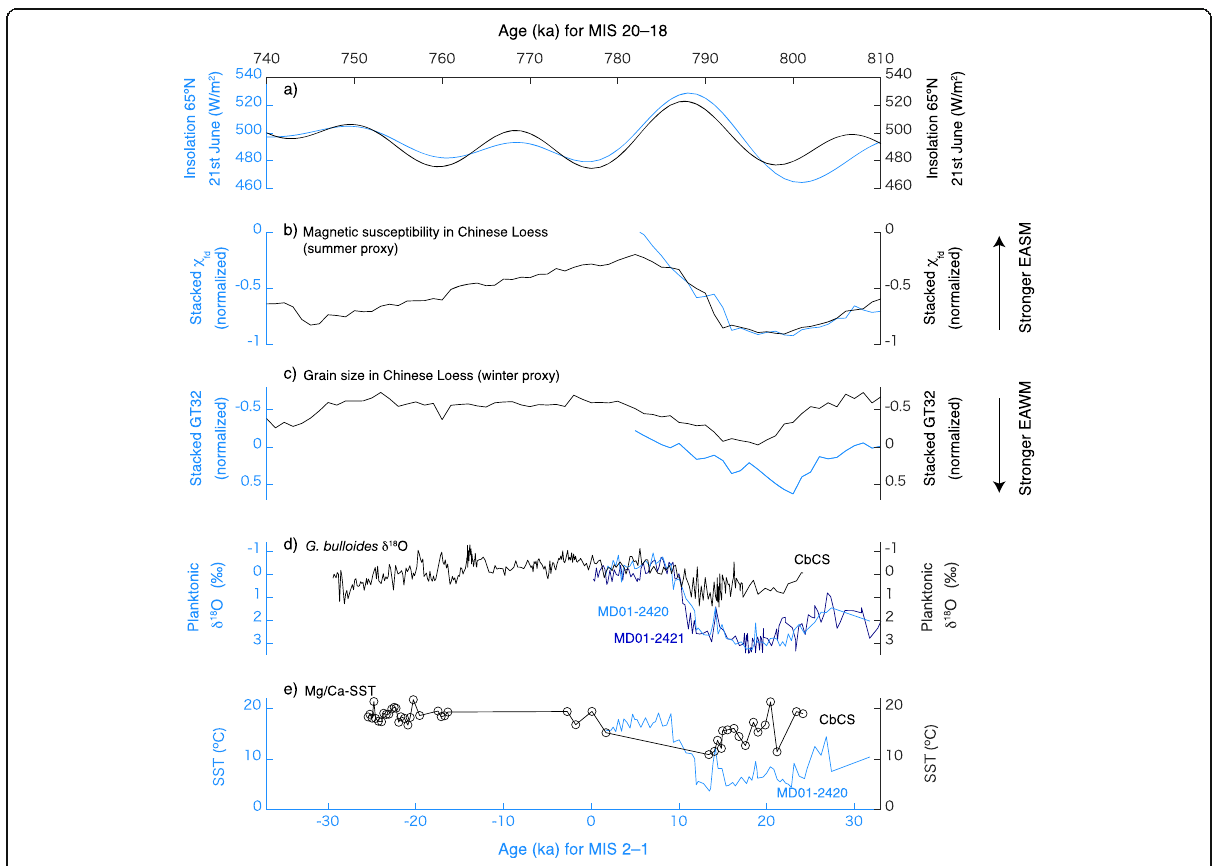
Fig. 6 A comparison between MIS 2 – 1 and MIS 20 – 18 with bottom axis for the age for MIS 2 – 1 and top axis for the age for MIS 20 – 18. a Northern Hemisphere summer insolation at 65° N for MIS 2 – 1 (blue) and MIS 20 – 18 (black), b , c proxies from the Yimaguan and Luochuan sections of the Chinese Loess Plateau showing b stacked grain size (EAWM) and c stacked magnetic susceptibility (EASM) (Hao et al. 2012) for MIS 2 – 1 (blue) and MIS 20 – 18 (black), d , e the planktonic foraminiferal ( G. bulloides ), d δ 18 O, and e Mg/Ca-based SST in the Kuroshio – Oyashio mixed zone for MIS 2 – 1 in MD01-2420 (blue, from Sagawa et al. 2006) and MD01-2421 for δ 18 O only (dark blue, from Oba et al. 2006), and MIS 20 – 18 (black, from the